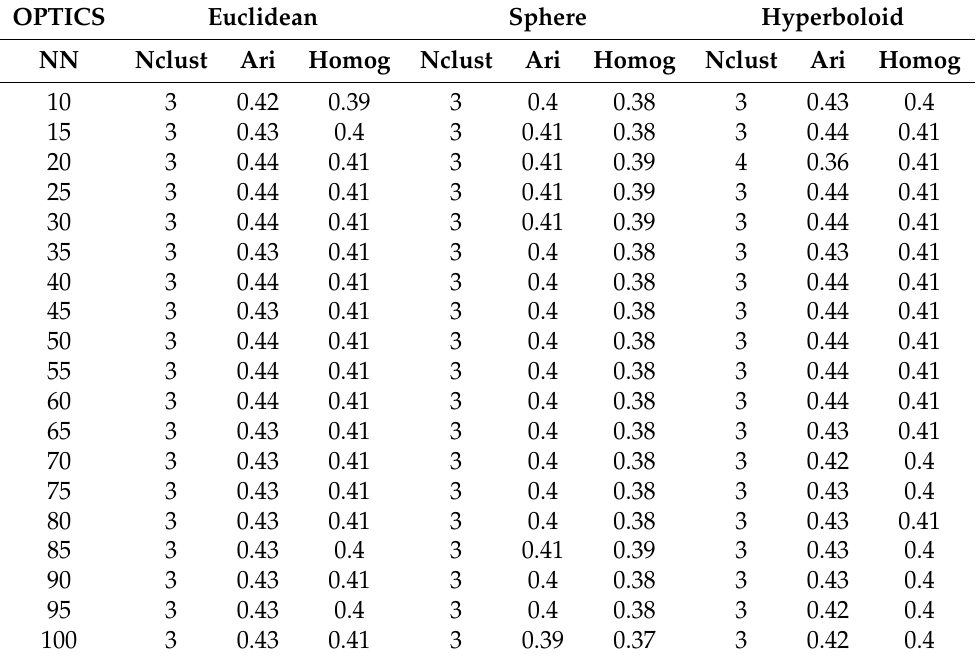
Table A3. Comparison of clustering performances. N c , ARI, and homogeneity score estimated for each NN and latent space (spherical, Euclidean, hyperbolic) for OPTICS and agglomerative clustering